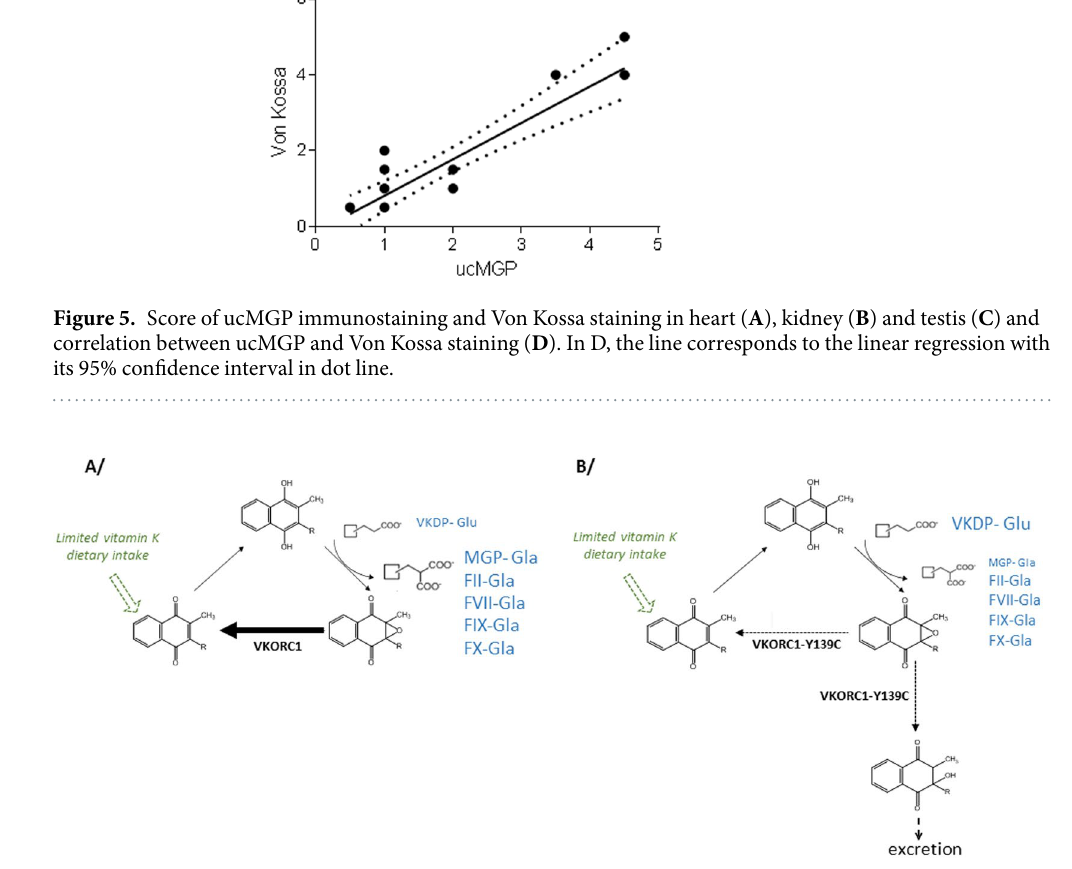
Figure 6. Mechanism of the development of vascular calcification in CC rat fed with a normal diet not supplemented with vitamin